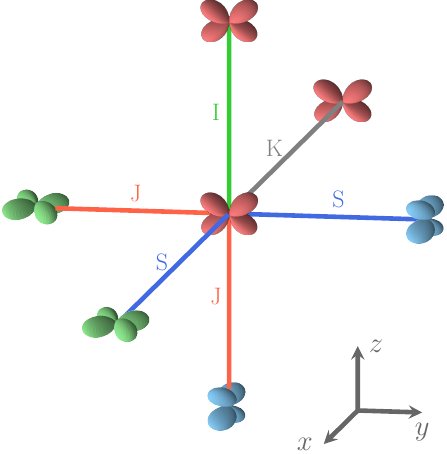
Figure 2. The four relative orientations (and then interactions) between first neighbor Fe atoms. Interaction types depend on d orbital labels and on the direction defined by the two Fe atoms. S and J interactions involve different d orbitals, and I and K connect identical d orbitals. In the Cartesian frame shows in the figure, d xy is green, d xz is blue, and d yz is red. For details, see